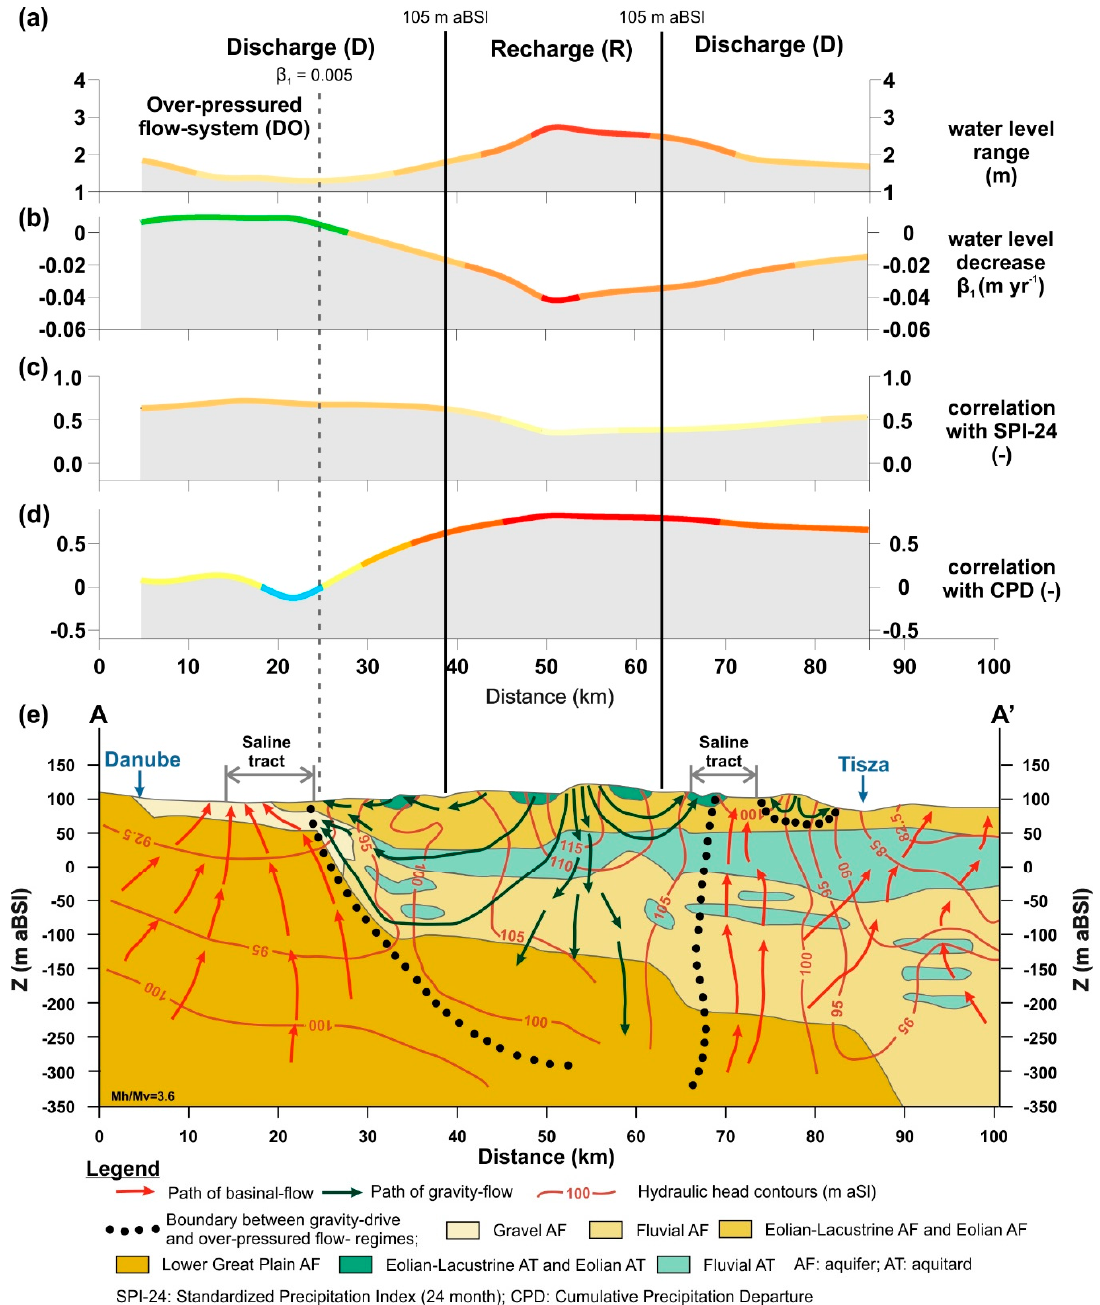
Figure 9. SGW level range (1961 to 2010) ( a ); slope of the linear regression ( β 1 ) ( b ); correlation with the Standardized Precipitation Index SPI-24 ( c ); correlation with the cumulative precipitation departure CPD ( d ); along the hydraulic cross section (Figure 1a) provided by Mádl-Sz ő nyi and Tóth [37] ( e ) . For further details on panel ( e ) see [37] . The color scale of the section lines (a–d) matches the original map color scale in Figures 3, 4, 6.